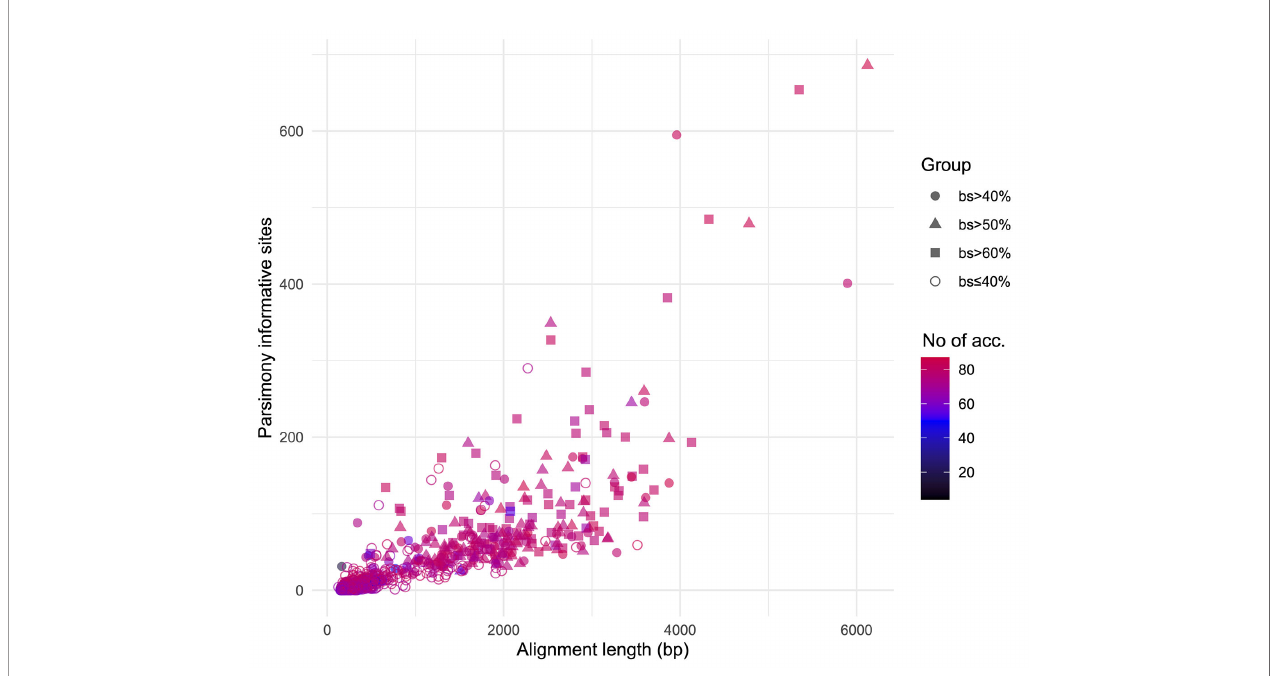
FIGURE 1 | Positive relation between alignment length and parsimony informative sites for the 832 loci obtained. Different shapes identify the subsets based on the threshold values of the upper quartile of rapid bootstrap support values obtained in RAxML for each gene tree. Colors indicate the number of accessions for which each loci was obtained.